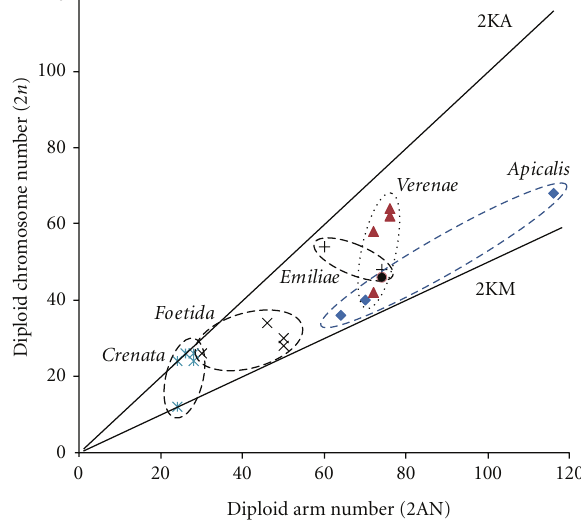
Figure 5: Karyograph of the Neotropical Neoponera according the Schmidt’s proposal. The ellipses circle the more representative species groups (last column of Table 1); an isolated black circle represents a single species ( P. marginata ) not incorporated in a